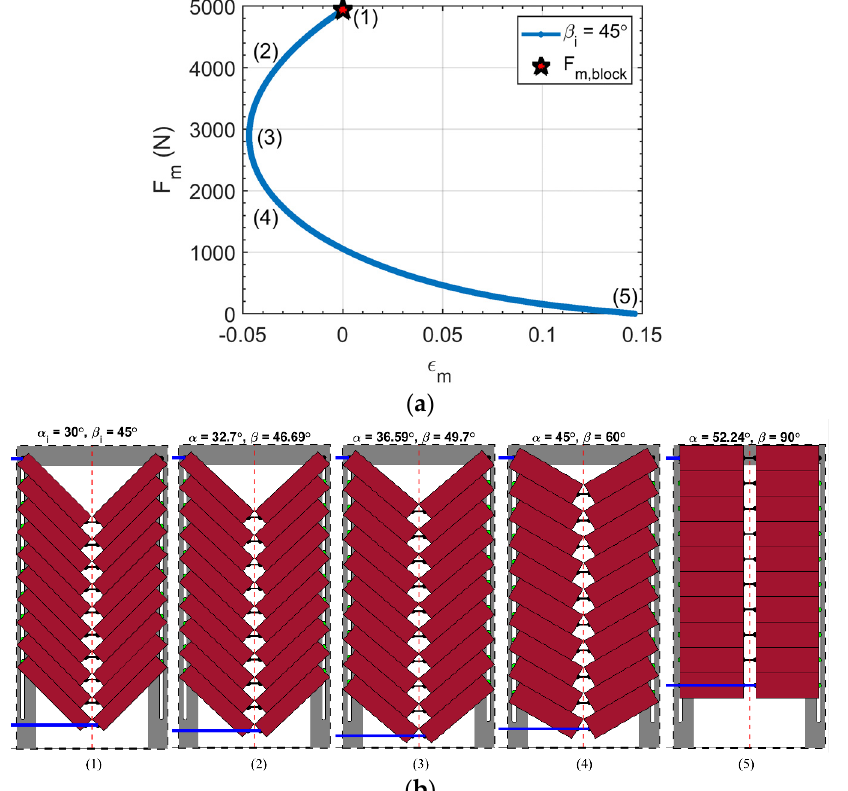
Figure 8. ( a ) Muscle force–muscle strain behavior of bipennate muscle bundle with β i = 45 ◦ and fiber contact boundary condition. The numbered label on the plot indicates the sequential change in muscle force and muscle strain during fiber actuation. ( b ) Visual representation of bipennate muscle bundle motion with fiber contact boundary condition. Each numbered image corresponds to different stages in fiber actuation and aligns with the numbered labels in (A). (1) is the initial or blocked force condition, (2) is ε m = − 0.025 during extensile motion, (3) is ε m = − 0.025 during contractile motion, (4) is when the muscle returns to its initial muscle length, and (5) is the free muscle contraction condition.